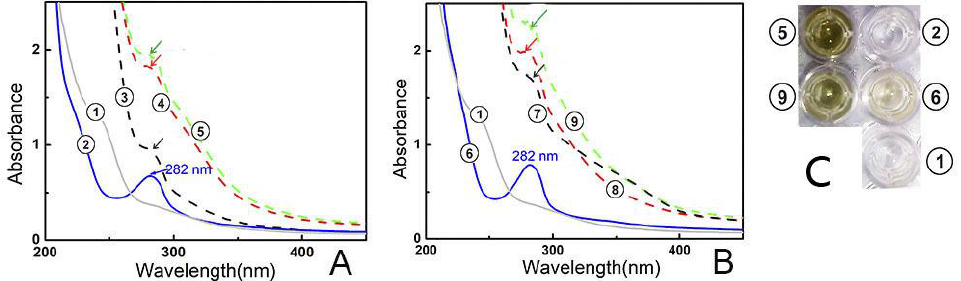
Figure 6. The experimental results of UV-vis-spectra analysis of Fe 2+ -chelation with kukoamine A and B. ( A ) kukoamine A; ( B ) kukoamine B; ( C ) solution appearances. ( ① 151.0 mmol/L Fe 2+ ; ② 0.2 mmol/L kukoamine A; ③ reaction mixture of 151.0 mmol/L Fe 2+ with 0.2 mmol/L kukoamine A for 0 min; ④ reaction mixture of 151.0 mmol/L Fe 2+ with 0.2 mmol/L kukoamine A for 30 min; ⑤ reaction mixture of 151.0 mmol/L Fe 2+ with 0.2 mmol/L kukoamine A for 60 min; ⑥ 0.2 mmol/L kukoamine B; ⑦ reaction mixture of 151.0 mmol/L Fe 2+ with 0.2 mmol/L kukoamine B for 0 min; ⑧ reaction mixture of 151.0 mmol/L Fe 2+ with 0.2 mmol/L kukoamine B for 30 min; ⑨ reaction mixture of 151.0 mmol/L Fe 2+ with 0.2 mmol/L kukoamine B for 60 min).